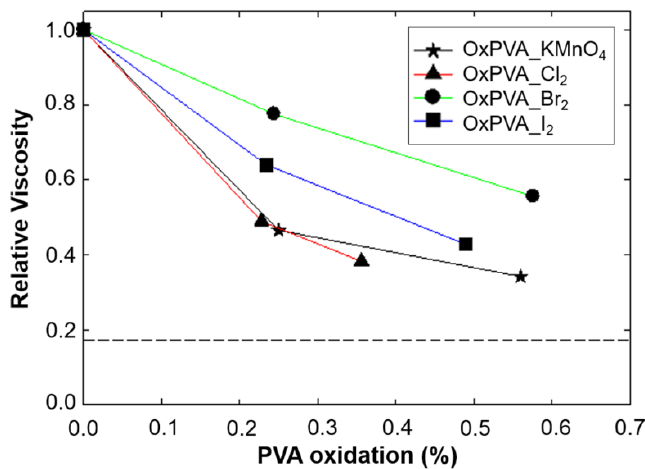
Figure 3. Viscosity measurements after PVA oxidation. Relative viscosity of oxidized PVA solutions was measured after dissolving 2% (w/w) of polymer into water at 20 °C and using a solution of 2% neat PVA as a reference. The dotted line represents relative viscosity of water.